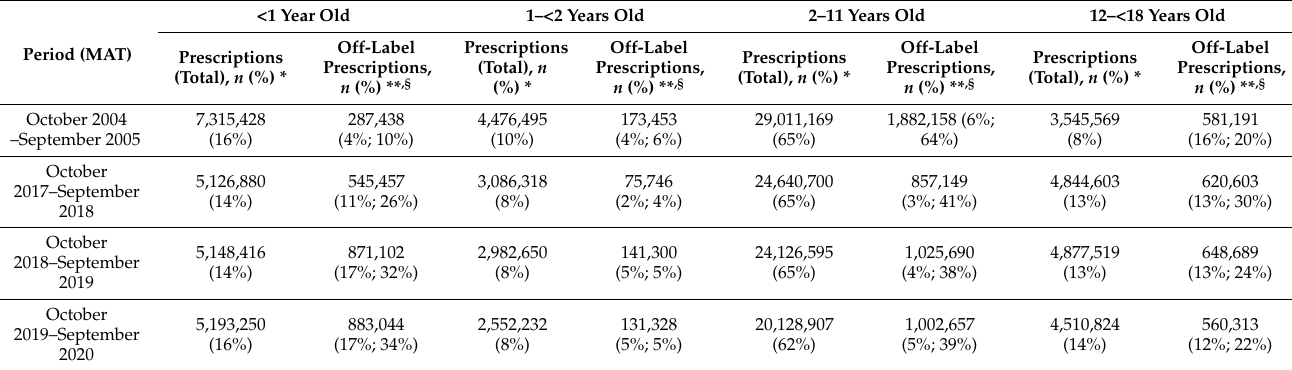
* Percentage calculated over total prescriptions in the population under the age of 18; ** Percentage calculated over total prescriptions in the population group; § Percentage calculated over total off-label prescriptions in the population under the age of 18. Abbreviations: MAT, moving annual total (12-month